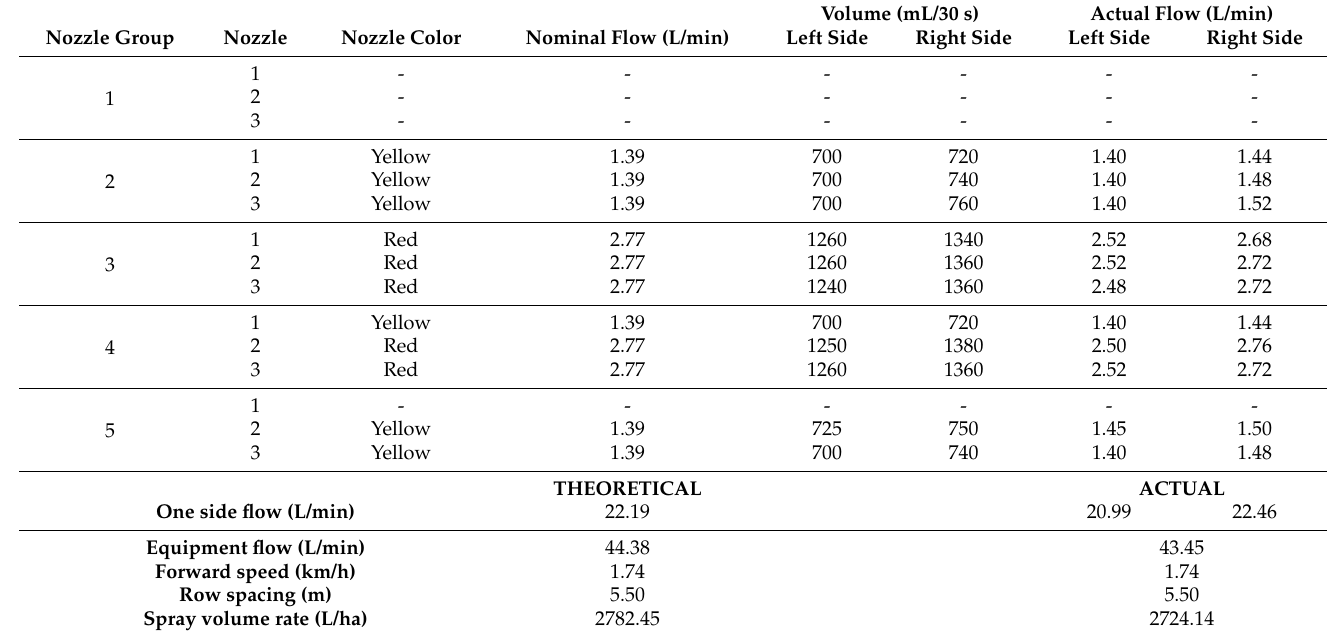
Table A7. Selection and calibration of nozzles for the T sprayer, with the following configuration: Adjusted to the vegetation/High & Low fan speed/High spray volume rate/Drift-reducing nozzles (Coarse)/Pressure: 9 bar.